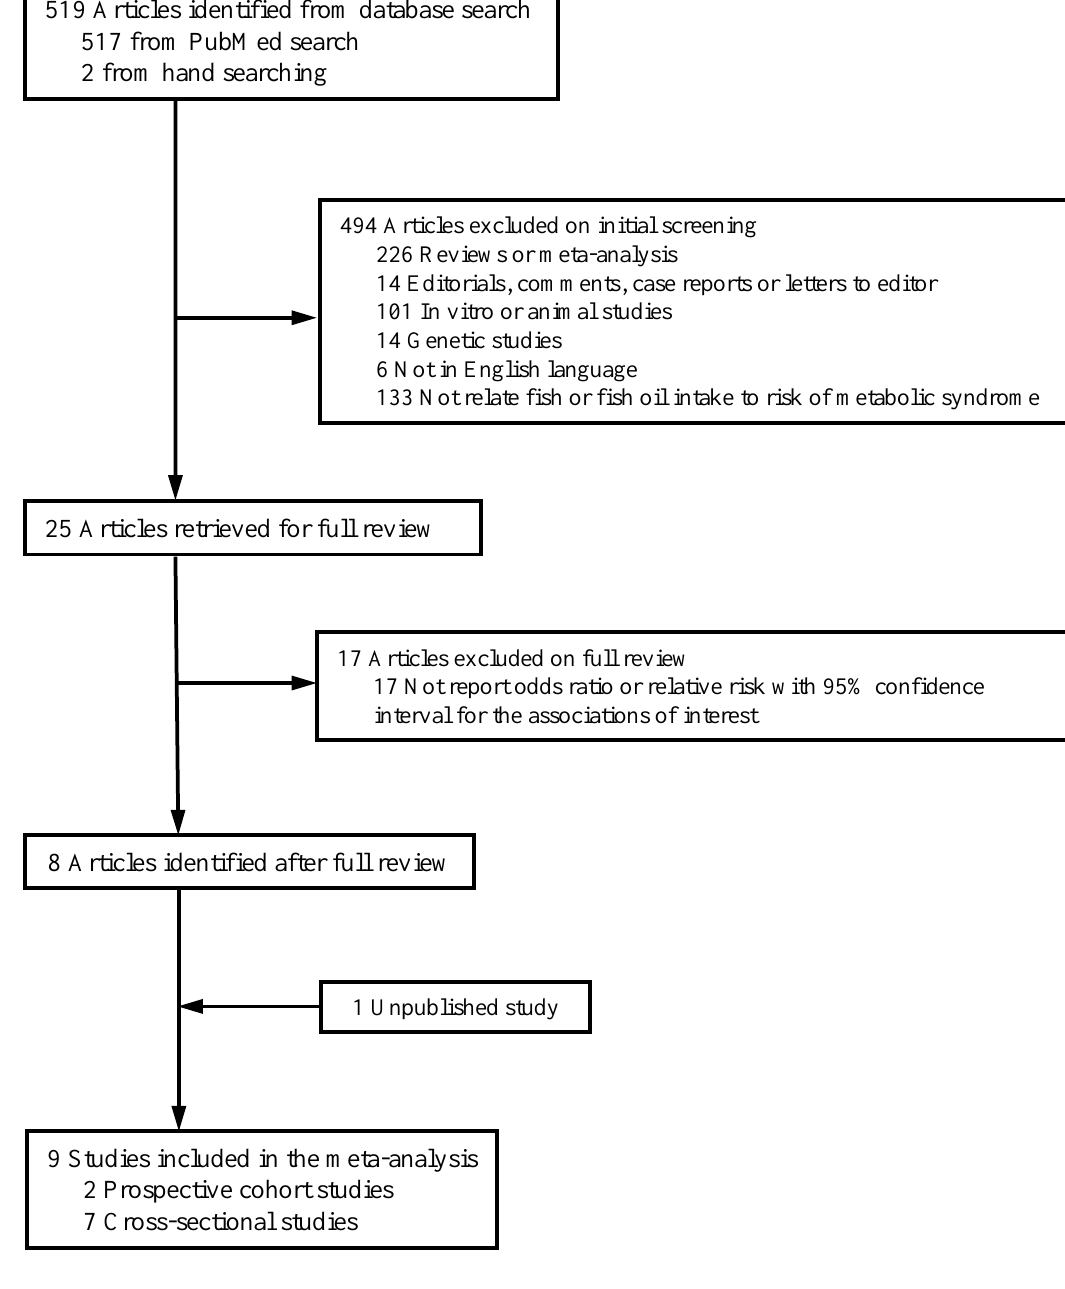
Figure 1. Process of study